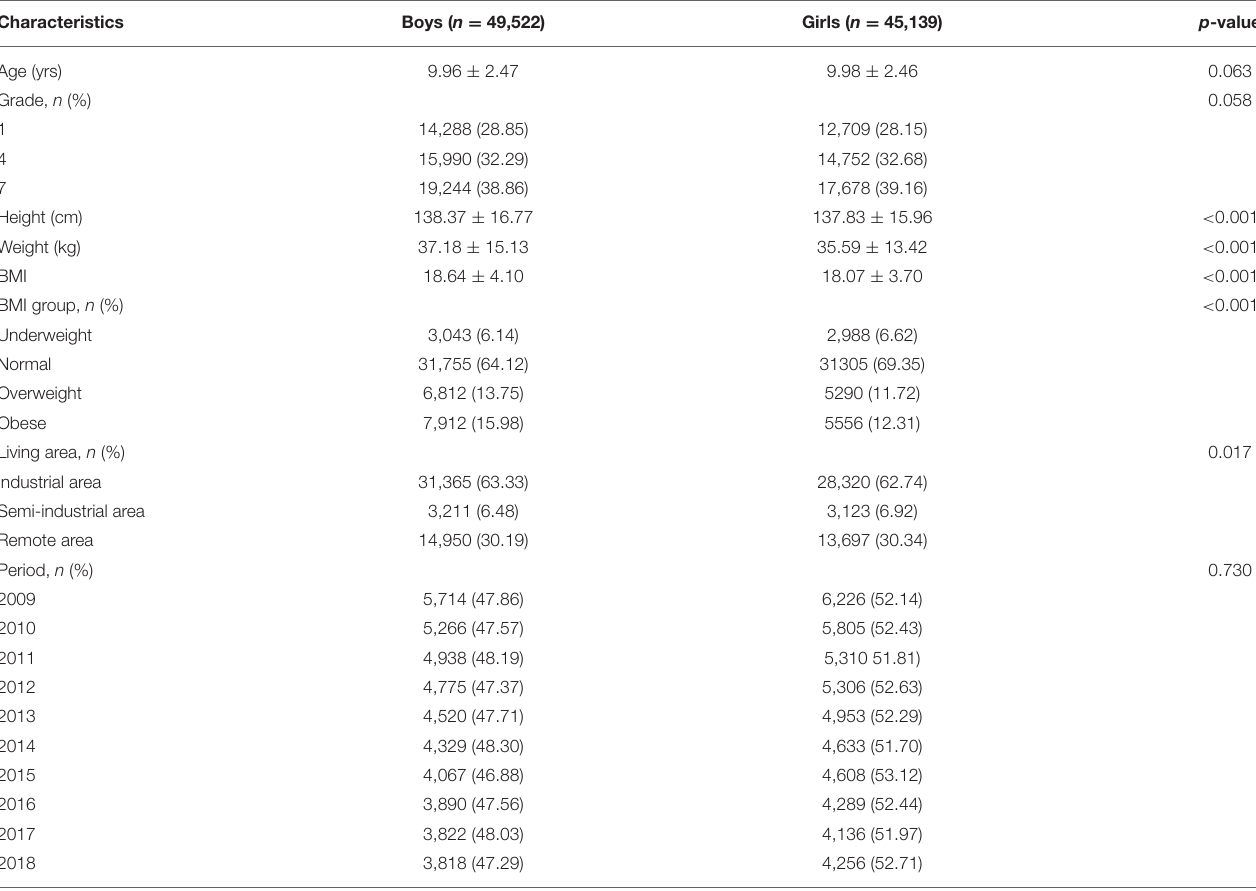
TABLE 2 | Sample characteristics among boys and girls.